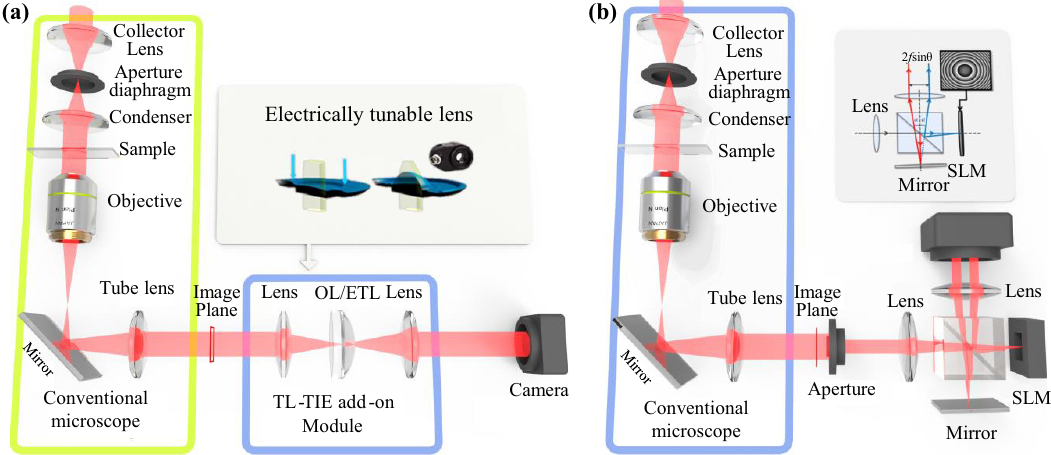
Figure 18. Advanced experimential setups for dynamic TIE phase imaging, which can be implemented as a simple add-on module to a conventional microscope. ( a ) electrically tunable lens based TIE microscopy system (TL-TIE) (adapted with permission from [78], Optical Society of America); ( b ) single-shot TIE system based on a SLM (SQPM); adapted with permission from [122], Optical Society of